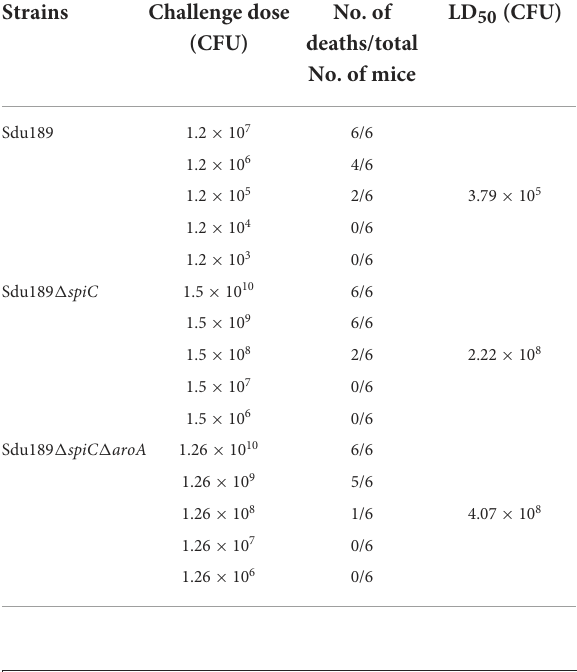
TABLE 2 The LD 50 of S . Dublin Sdu189, Sdu189 1 spiC and Sdu189 1 spiC 1 aroA, in 6-week-old mice after intramuscular immunization.